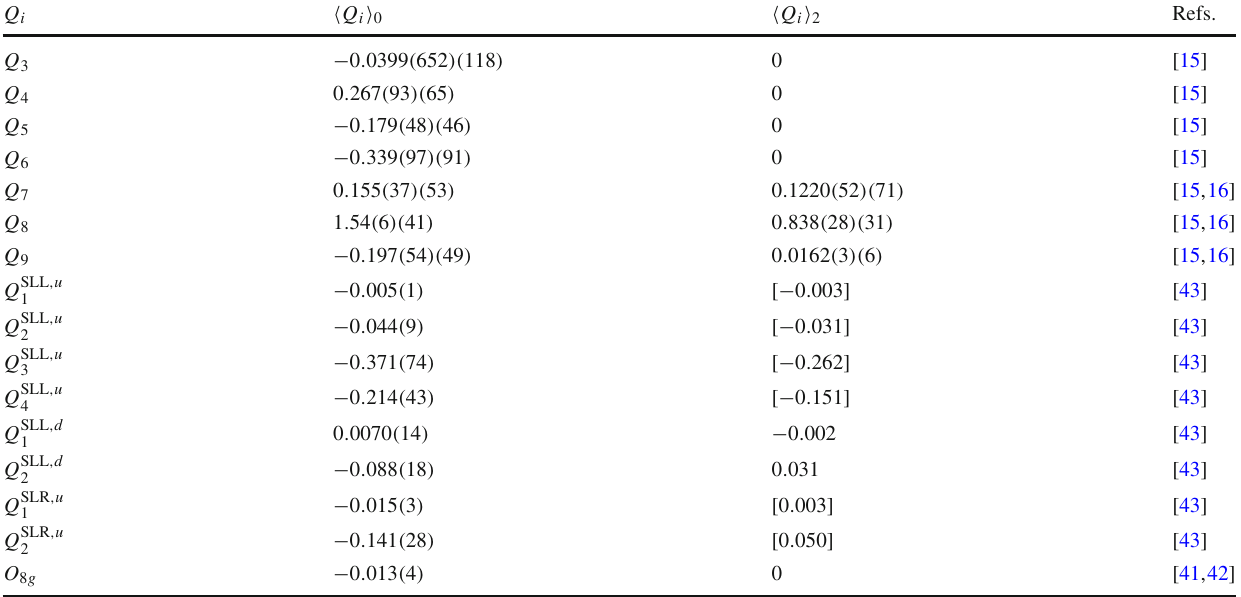
in units of GeV 3 . The normalization convention is chosen as h = 1 (at variance with Refs. [15,16]). The values in square brackets are not needed since they can be expressed in terms of the others by isospin and Fierz relations. Note that the chromo-magnetic matrix element refers to our convention, see (6)